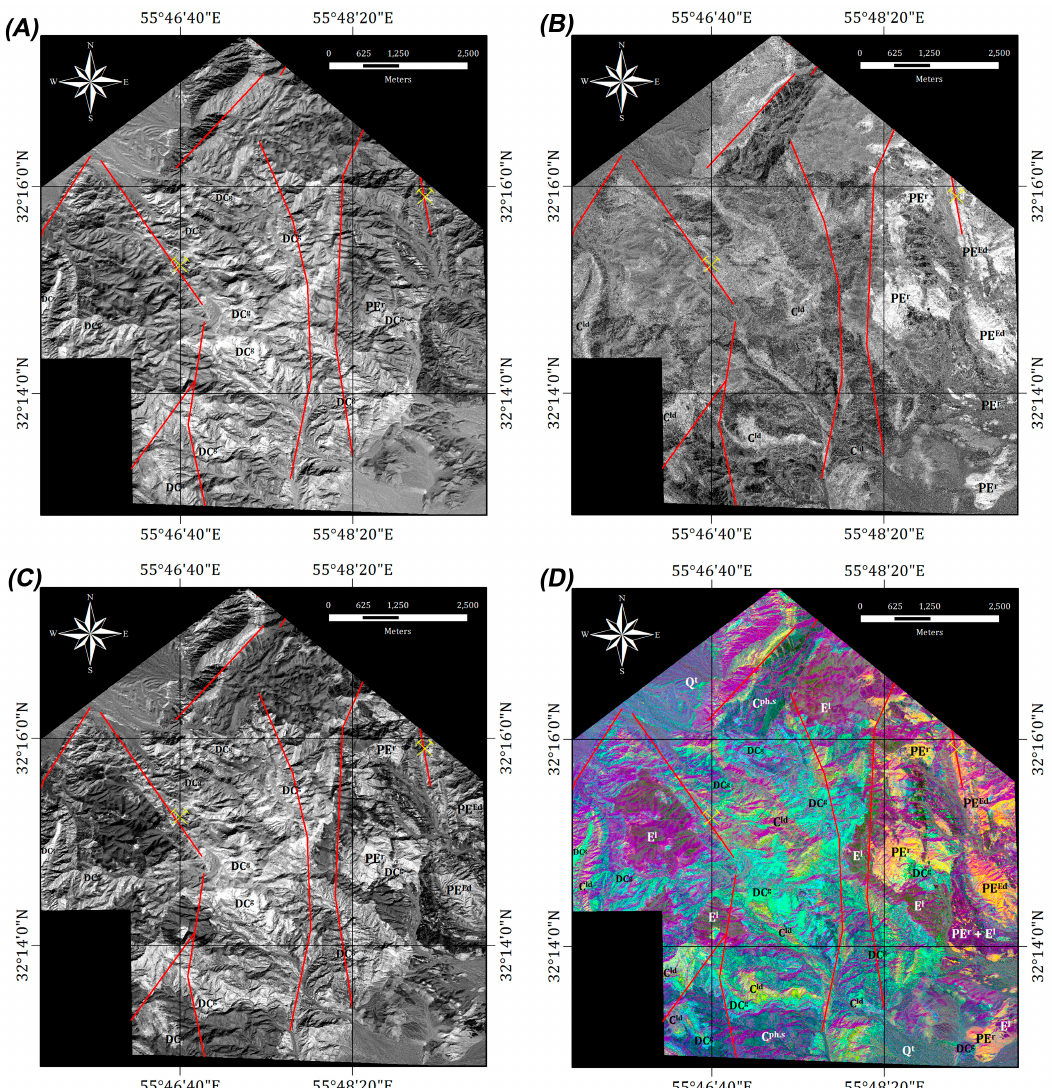
Figure 11. WV-3 scene covering the selected subset of the study area containing Zn–Pb mineralization. ( A ) The PC3 image-map showing iron-stained alteration as bright pixels; ( B ) the PC4 image-map showing dolomite/Fe 2+ as bright pixels; ( C ) the PC6 image-map showing Fe 3+ oxides as bright pixels; ( D ) RGB false color composite image-map of the PC4, PC6 and PC3 discriminates lithological units.